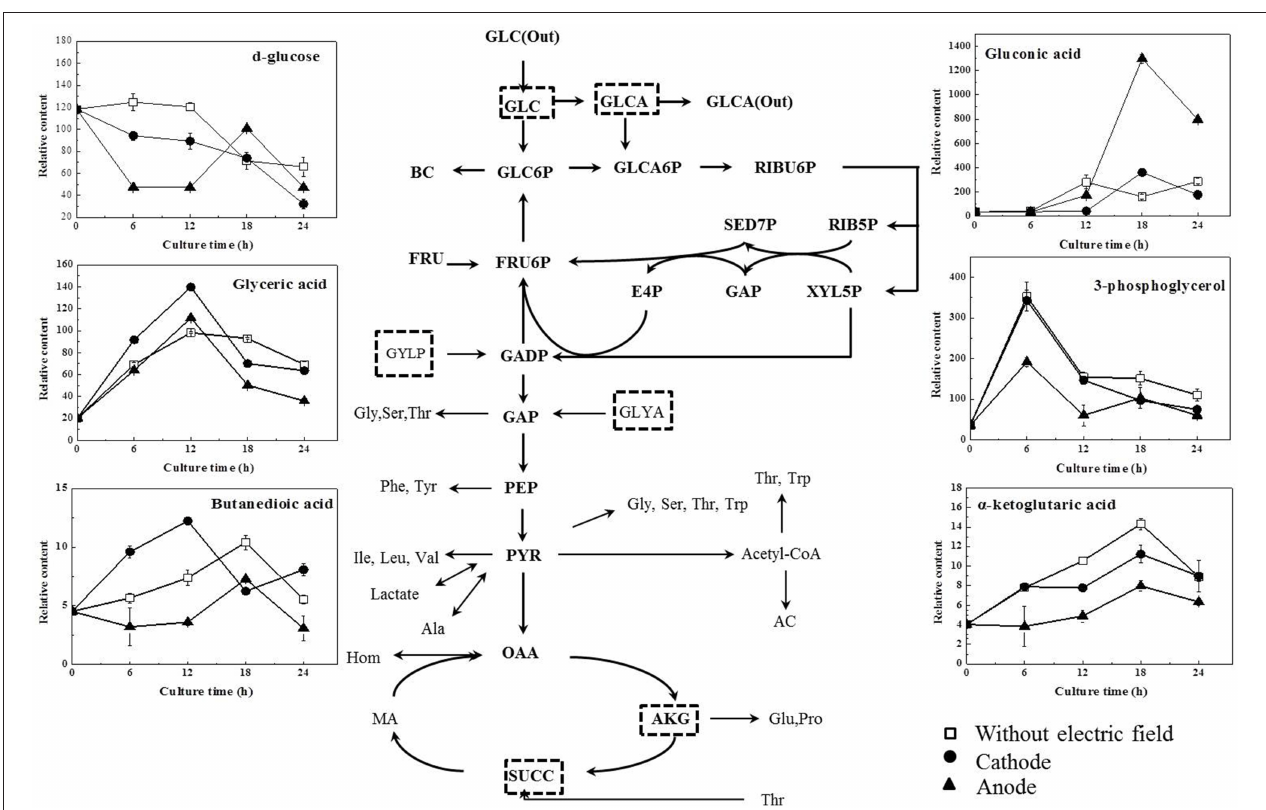
FIGURE 8 | Overall schemes of metabolites relative content changes mapped onto the metabolic network. (Diamonds, without electric field; round, cathode of DC electric field; triangle, anode of DC electric field). GLC, glucose; GLCA, Gluconic acid; BC, Bacterial Cellulose; UDPG, Uridine diphosphoglucose; GLC6P, Glucose-6-phosphate; RIBU5P, Ribulose-5-phosphate; RIB5P, Ribose-5-phosphate; XYL5P, Xylulose-5-phosphate; SED7P, Sedoheptulose-7-phosphate; E4P, Erythrose-4-phosphate; FRU6P, Fructose-6-phosphate; G3P, 3-Phosphoglycerate; GAP, Glyceraldehyde-3-phosphate; G3P, glycerol-3-phosphate; GLYA, glyceric acid; PEP, Phosphoenol pyruvate; PYR, Pyruvate; AC, Acetate; Ser, serine; Leu, leucine; Val, valine; Hom, homoserine; Glu, glutamic acid; Pro, proline; FA, fatty acid; HEX, hexadecanoic acid, OCT, octadecanoic acid; OCTE, octadecenoic acid; ACCOA, Acetyl-coenzyme A; OAA, Oxaloacetate; AKG, α -keto-gluterate; SUCC,